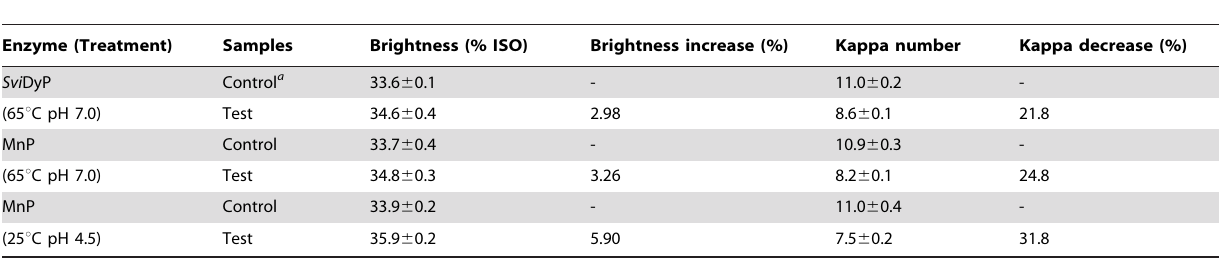
Table 4. Physicochemical properties of enzyme-treated eucalyptus kraft pulp.